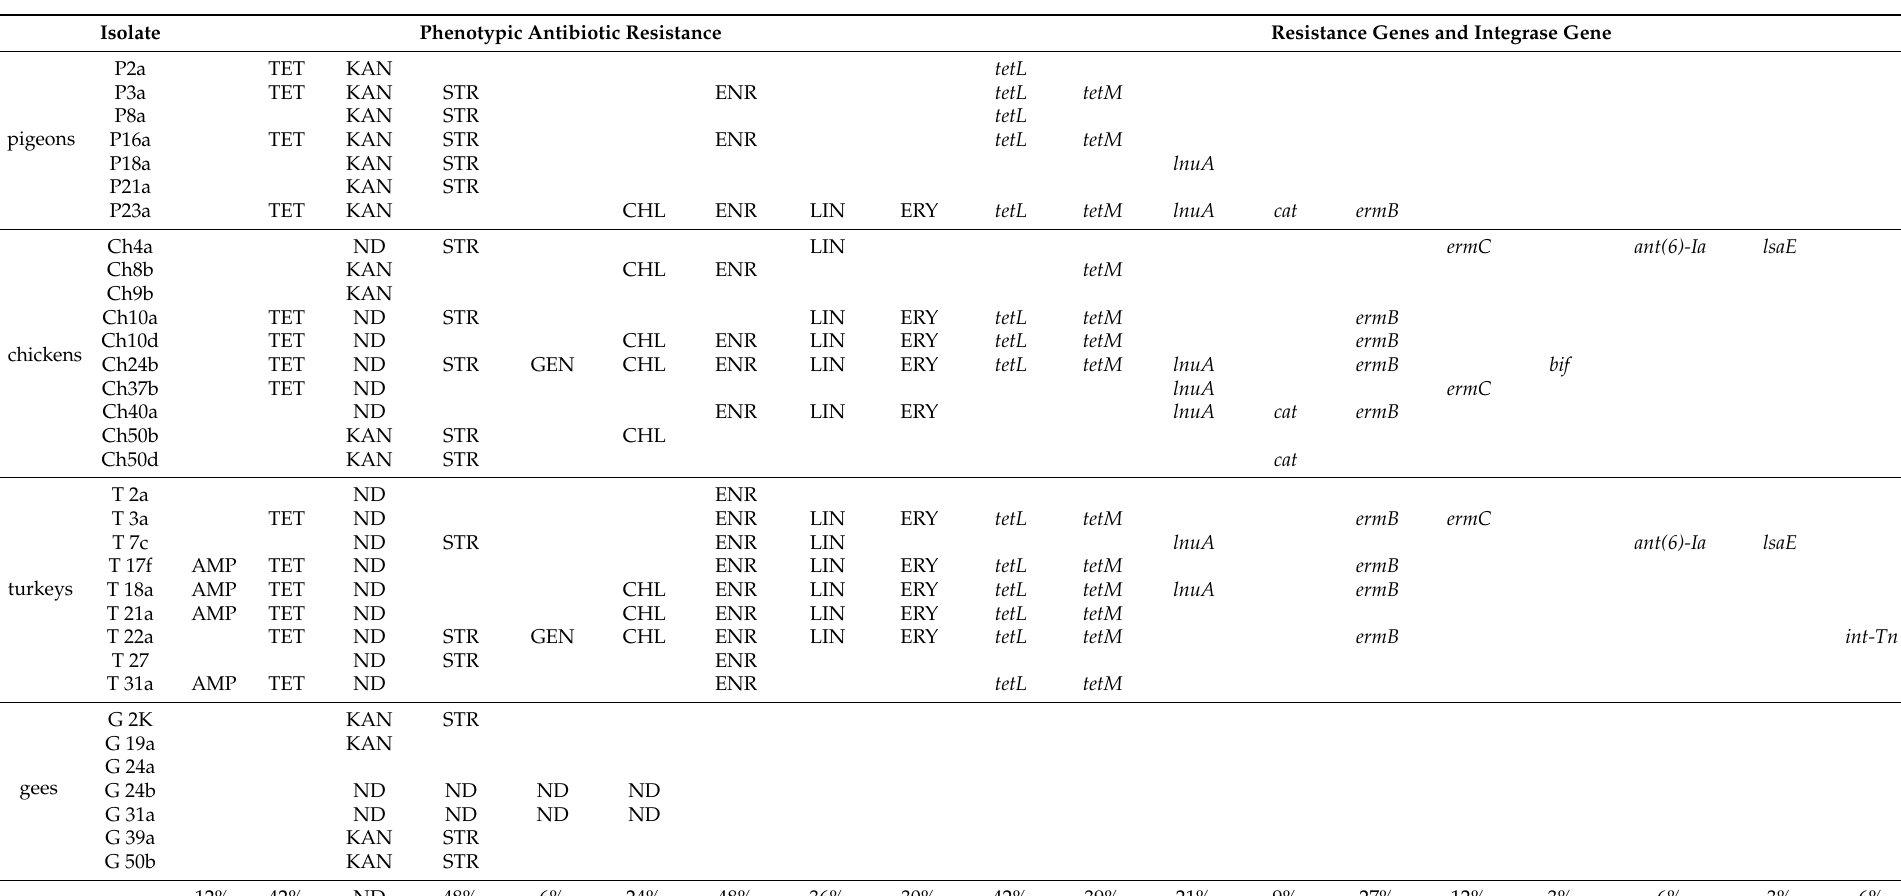
Table 4. Phenotypic and genotypic antibiotic resistance profiles of Ligilactobacillus salivarius